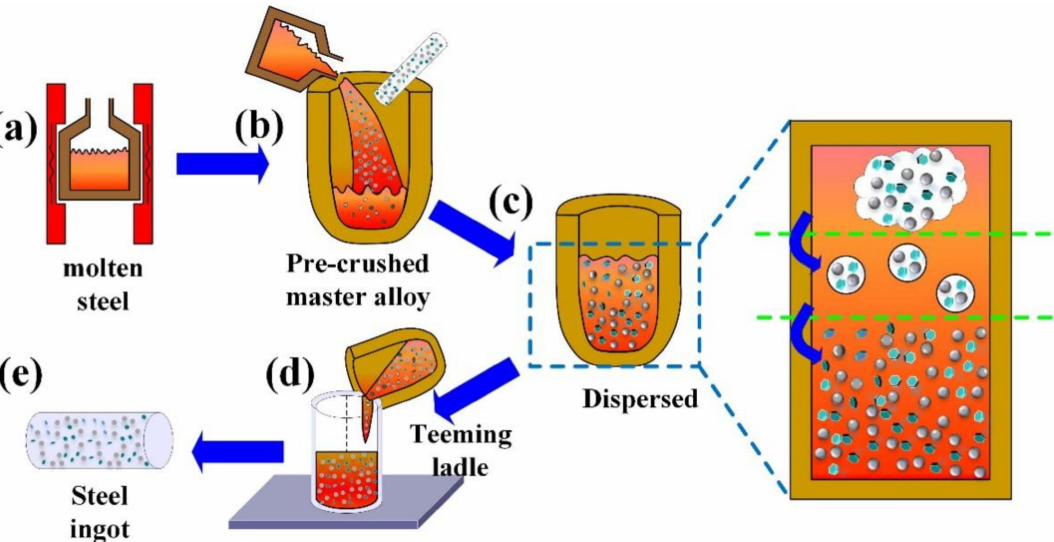
Figure 1. The preparation process of H13 tool and die steels manipulated by trace nanoparti- cles: ( a ) melt, ( b ) addition and release of nanoparticles, ( c ) uniform distribution of nanoparticles, ( d ) casting, ( e ) steel